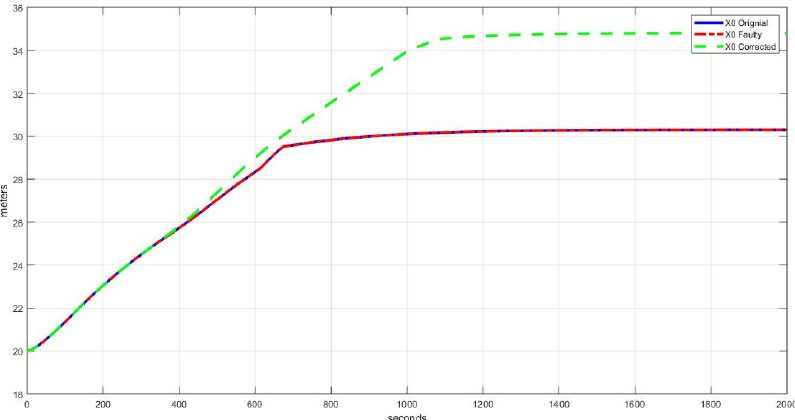
Figure 20. Pond 1 with normal, faulty, and fault-corrected operation given a sluice gate w 1 leakage fault.